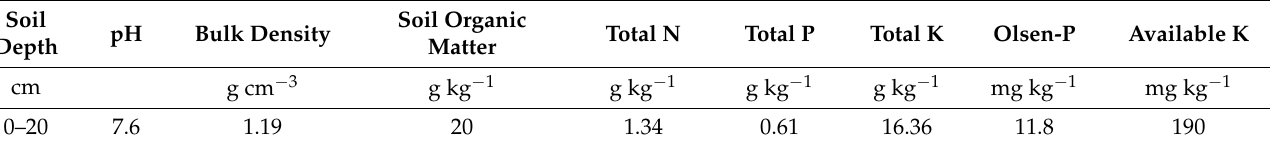
Table 1. Physical and chemical properties of studied soil in the experiment in